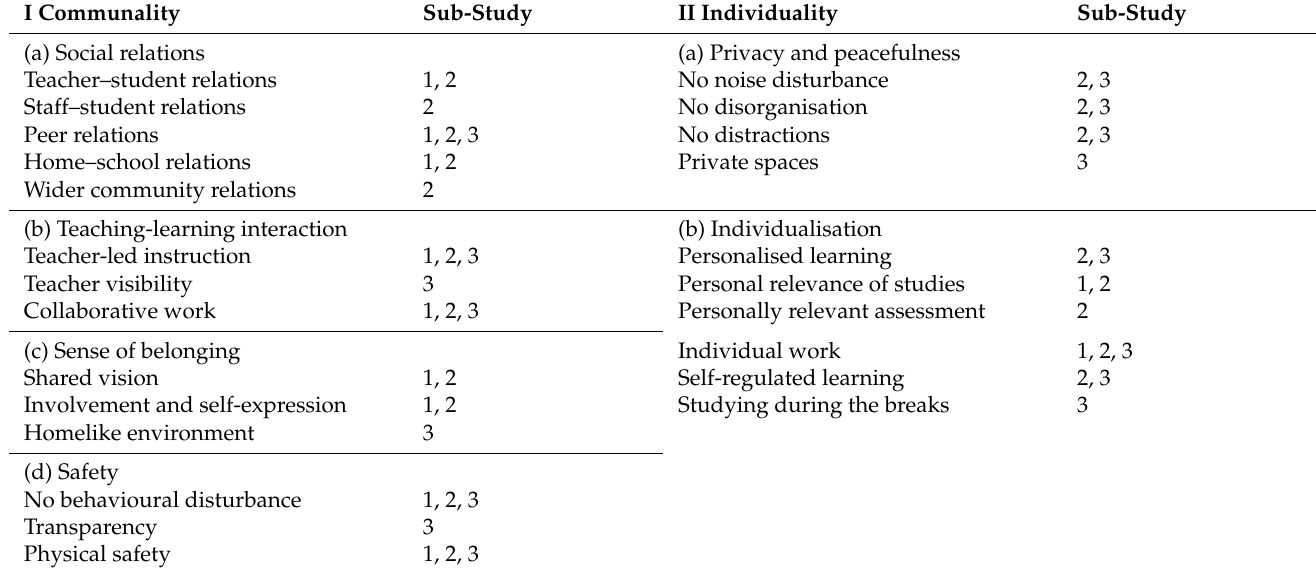
Table 2. Communality- and individuality-related characteristics confirmed or emerged in